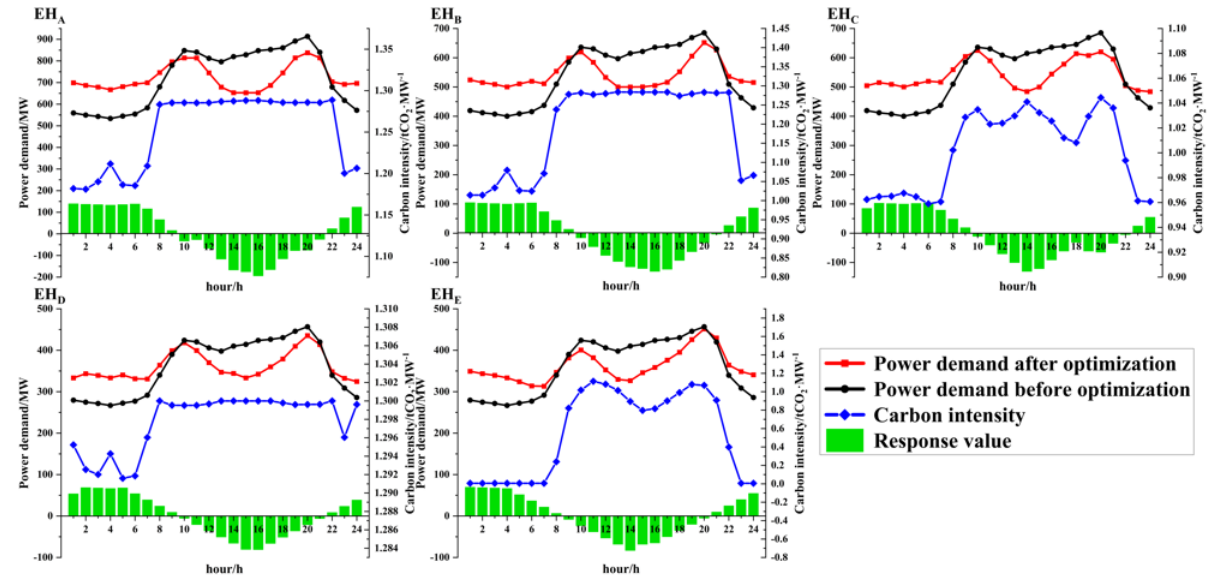
Figure 18. The response analysis diagram of each power demand in Scenario 2.